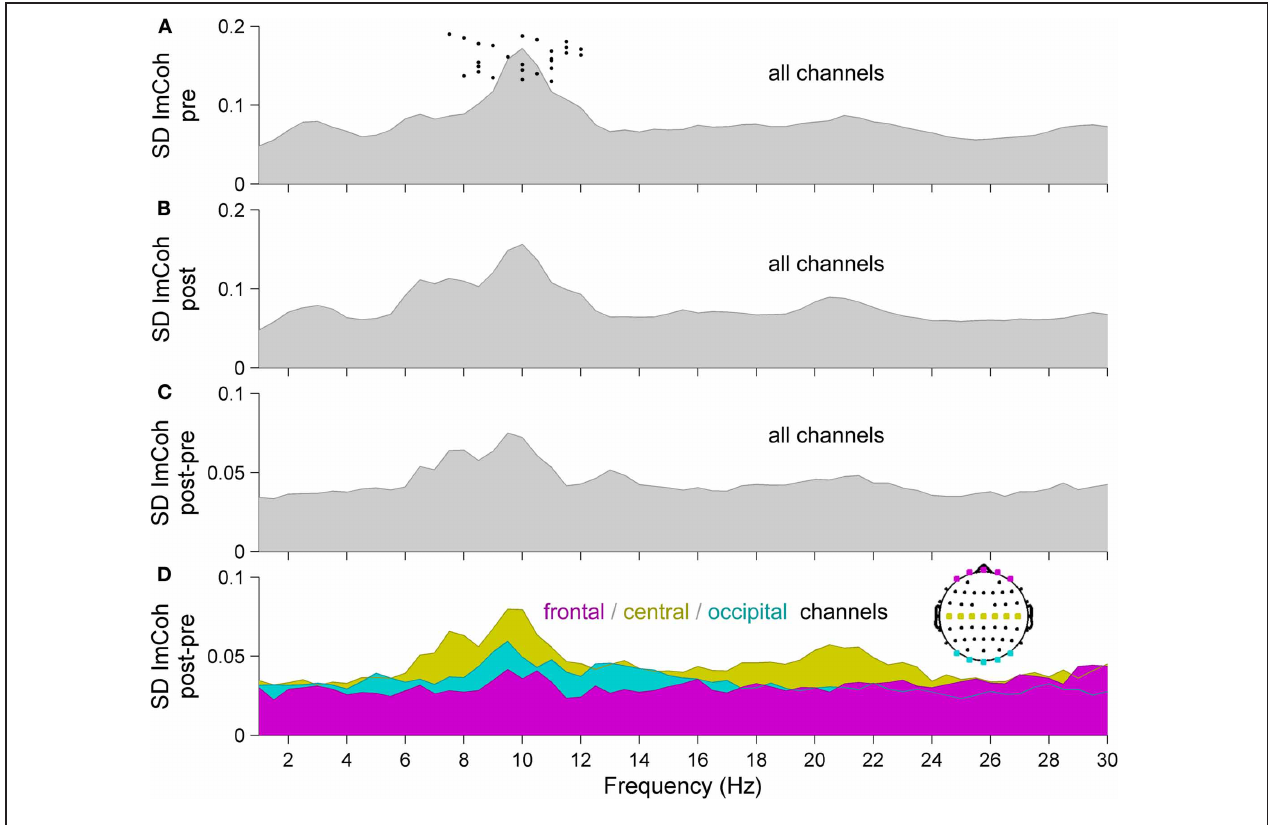
FIGURE 2 | Statistical dispersion of ImCoh-spectra for (A) pre- and (B) post-sessions and for (C,D) difference spectra post-pre, indicating the change between the two sessions. (A–C) Standard deviations (SD) across all subjects and all scalp channels. Before calculating the SD, spectra of all subjects were shifted so that their alpha peak frequencies coincide at 10Hz. Original alpha peak frequencies of all subjects are indicated as dots in panel A . (D) SD of ImCoh difference